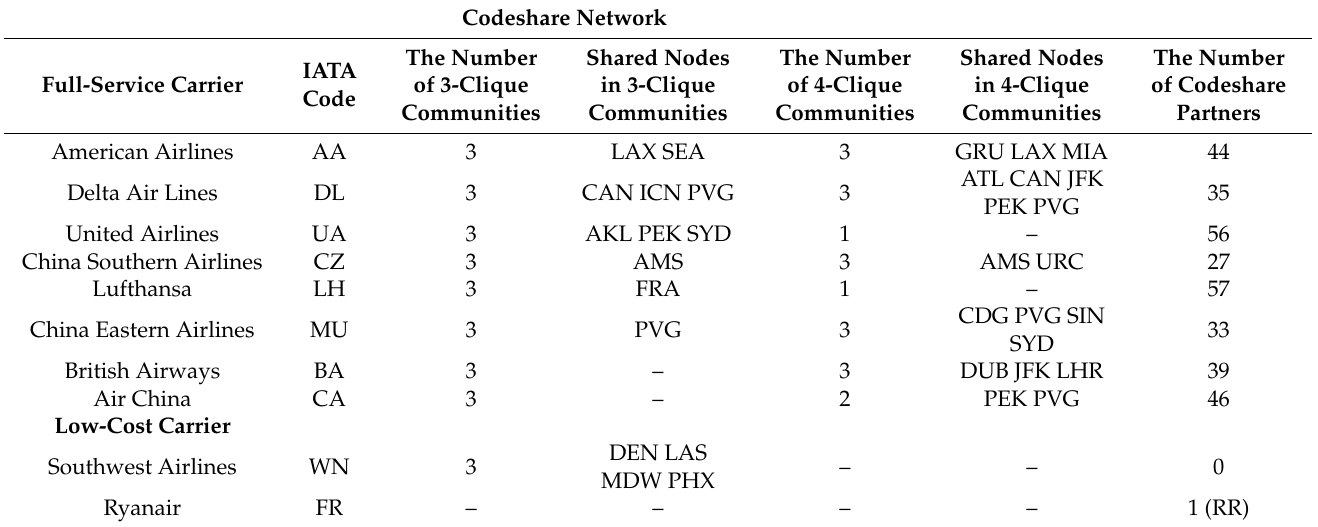
Table 4. Community detection results for codeshare networks of selected 10 airlines (excluded subsidiaries). Codeshare